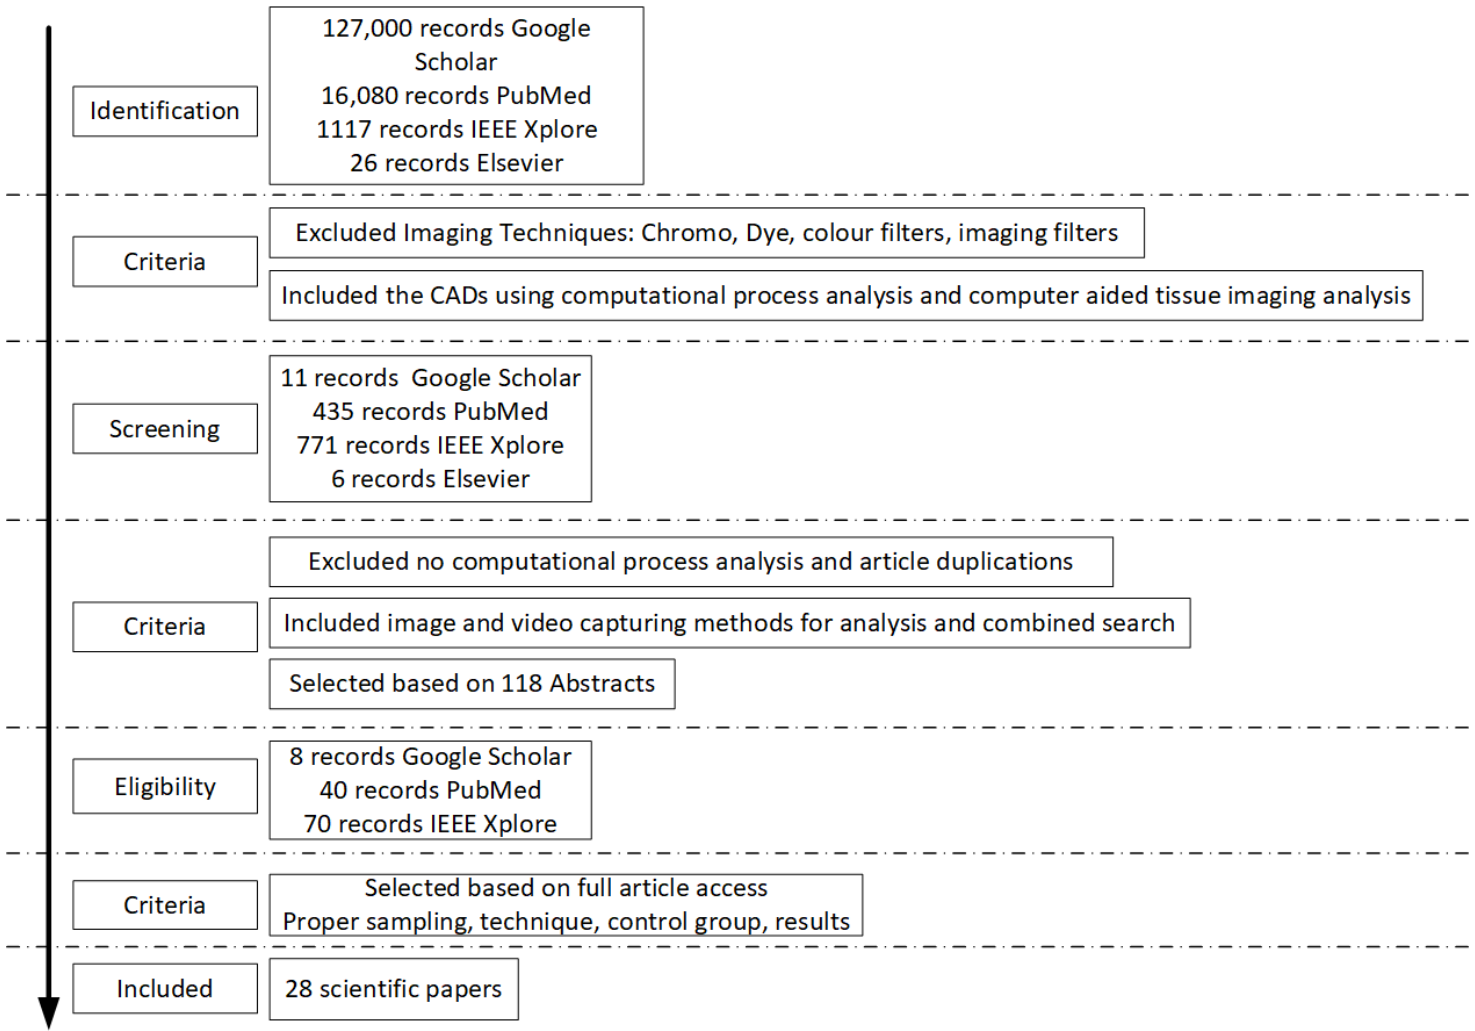
Figure 1. Summary of the search result papers and the evaluation procedure. Flow chart of the search strategy for the CATIA articles that appear in the literature.